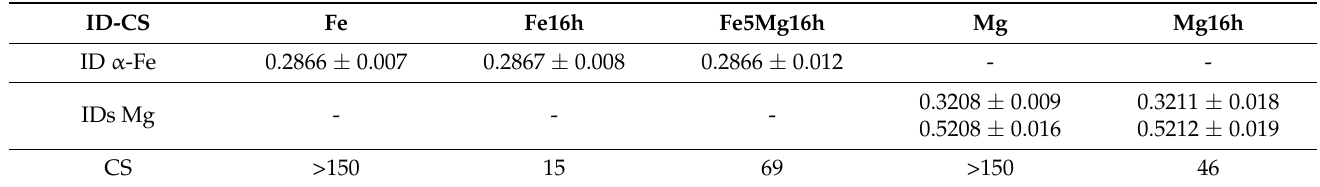
Table 1. Interplanar distances (ID, nm) corresponding to the [110] planes of α -Fe; and [1120] and [0001] planes of Mg; and crystallite sizes (CS, nm).